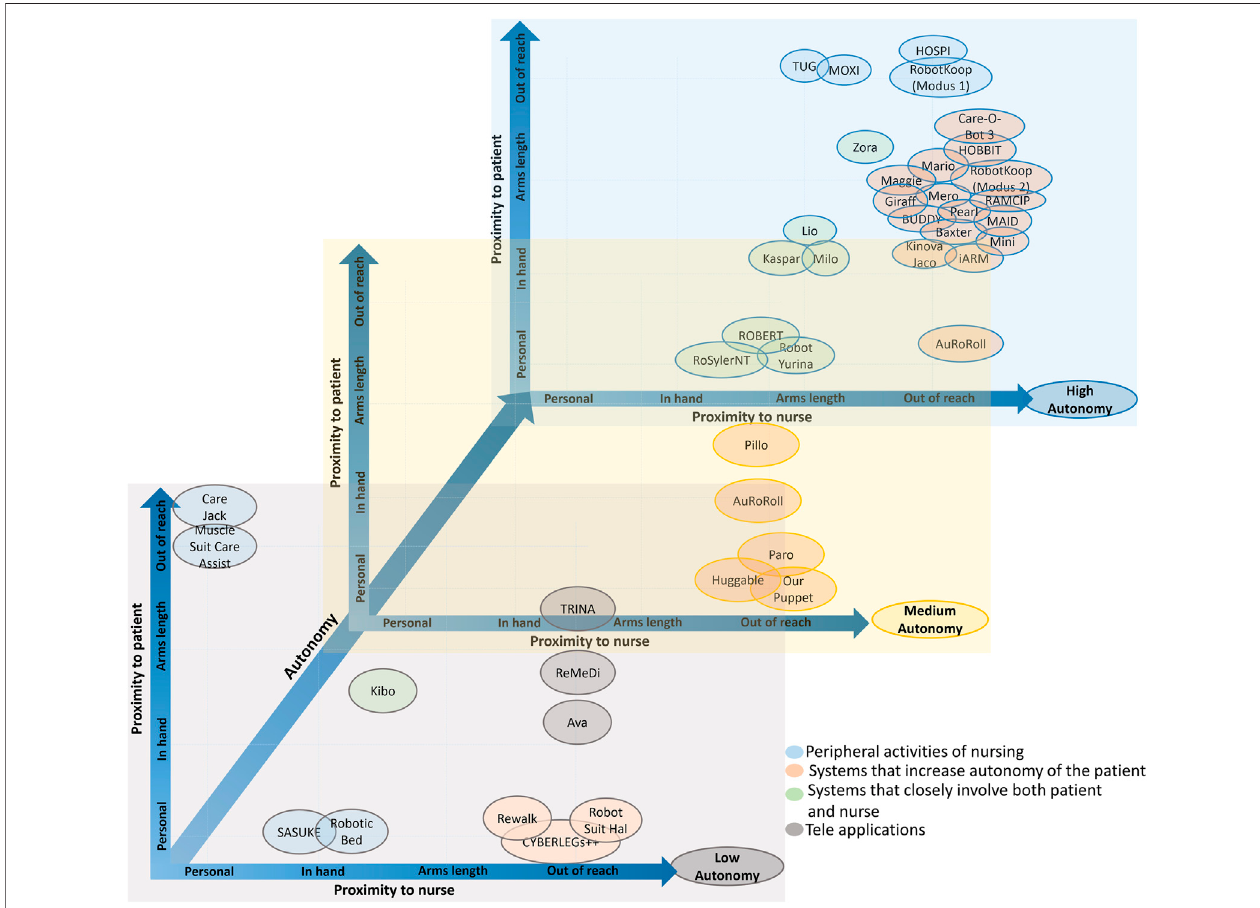
FIGURE 9 | Distribution of example projects according to autonomy and proximity to patient and caregiver.